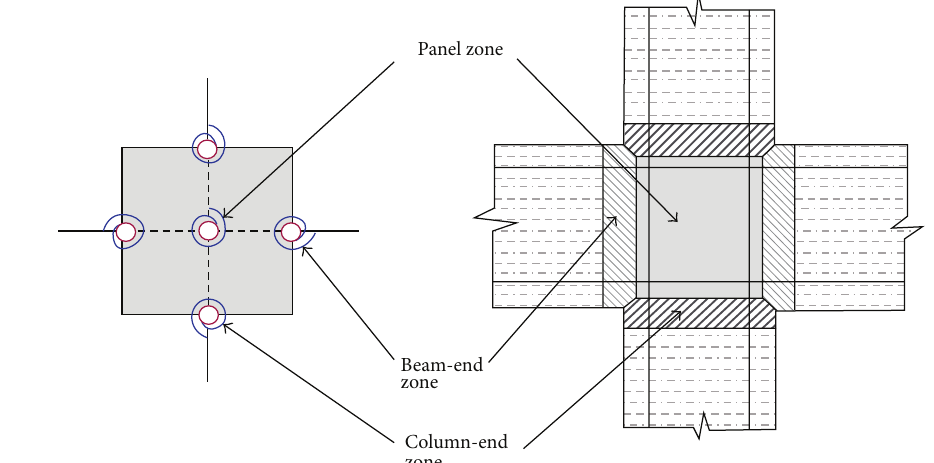
Figure 14: Configuration of the joint element